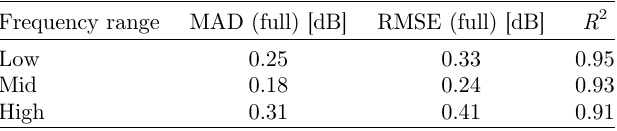
Figure 12. Visualization of the low frequency random forest predictions; the estimated CPX levels are color-coded, the dashed contour lines denote the kernel density estimates of the input data, thus marking the areas of model inter- and extrapolation.